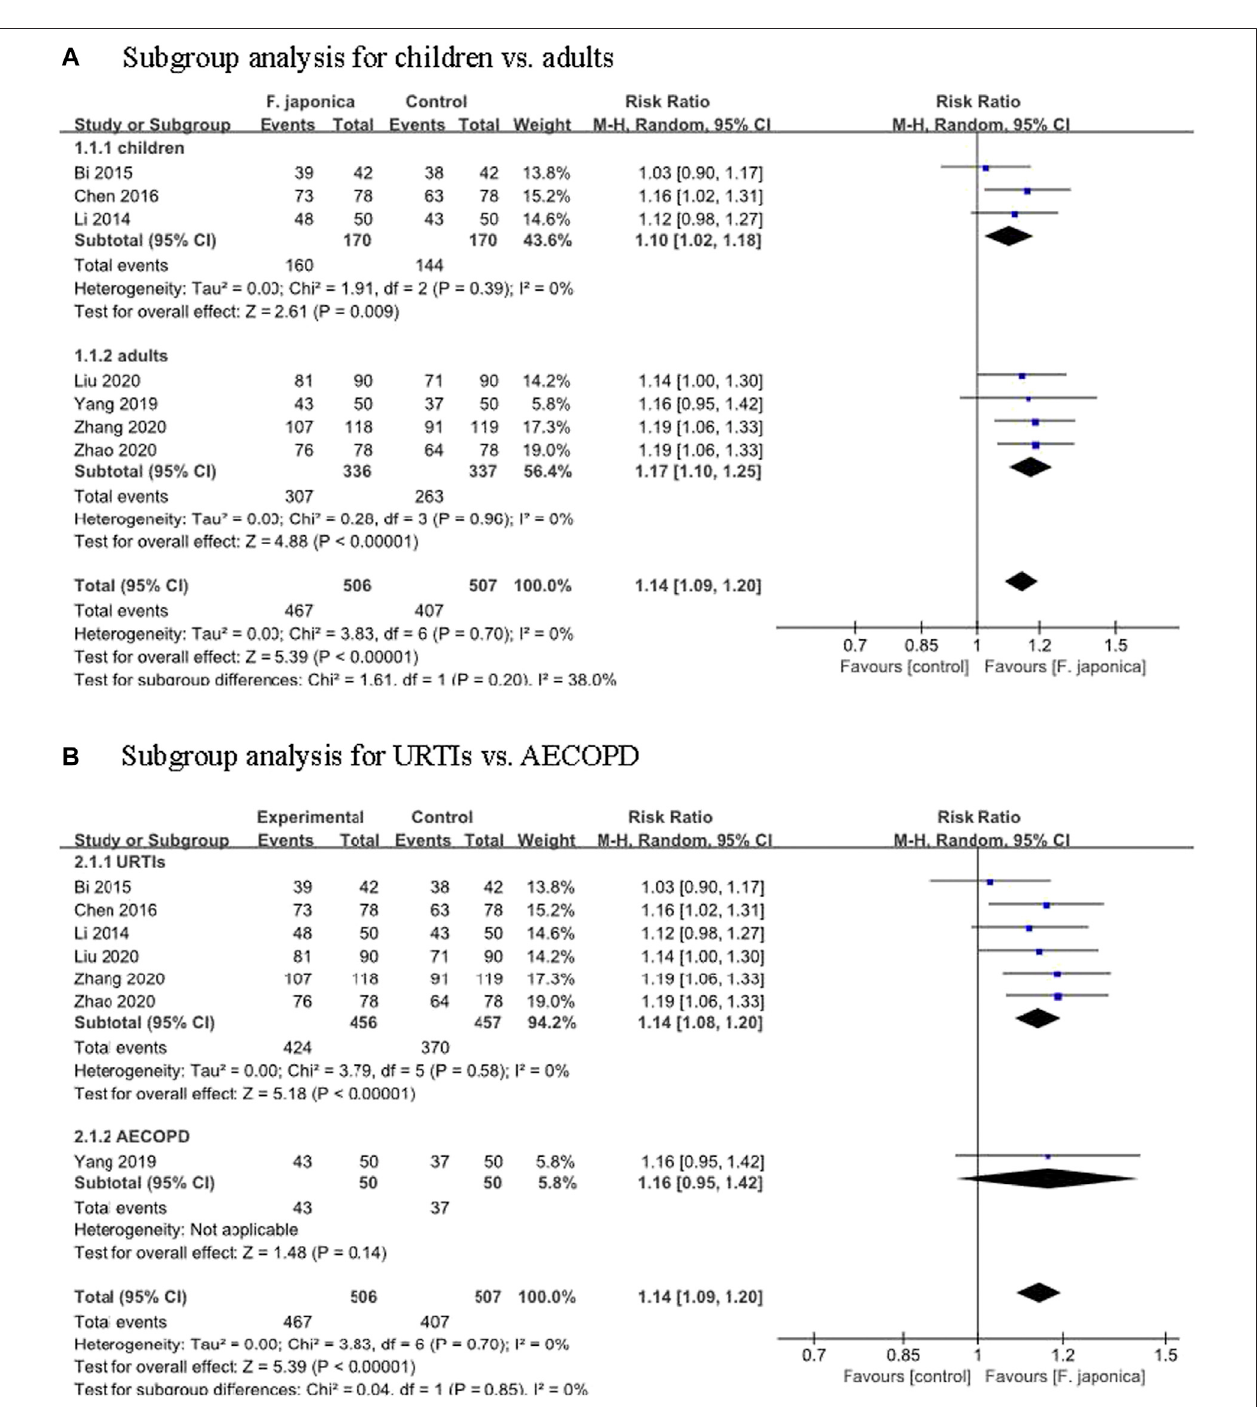
FIGURE 3 | Meta-analysis of symptom improvement rate (A) . Subgroup analysis for children vs. adults (B) . Subgroup analysis for URTIs vs. AECOPD.